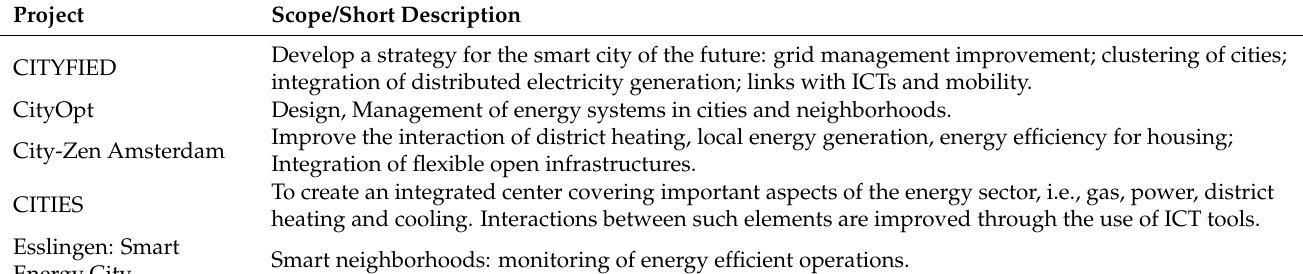
Table 7. Smart cities/smart building applications.